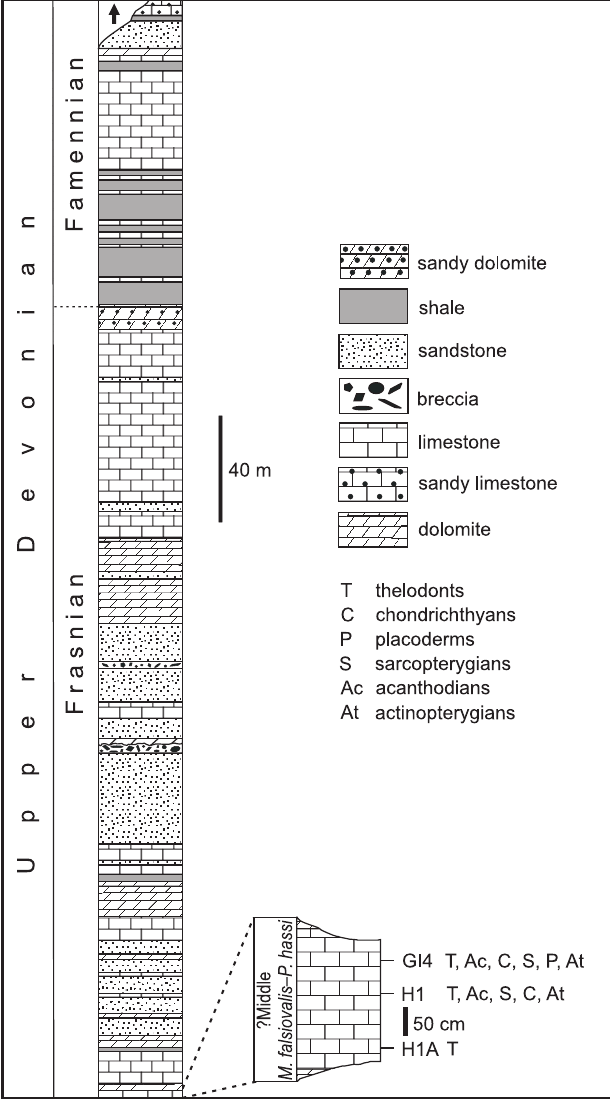
Fig. 2. Simplified stratigraphic column of the Chahriseh area with a magni− fication of the basal Frasnian deposits and position of acanthodian−bearing horizons H1 and